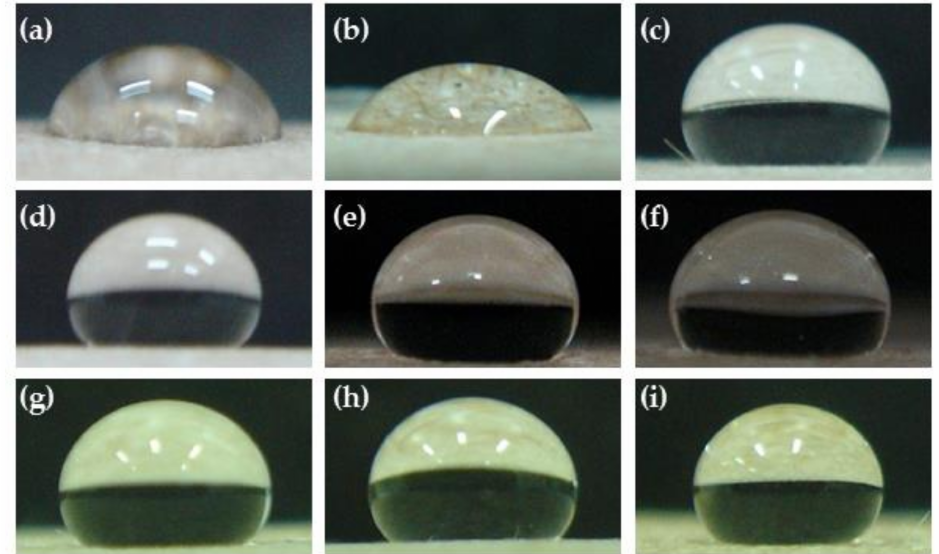
Figure 5. Effect of treatment time (minutes) on water droplets placed (40 µ L) at 200 mTorr and 50 Watts for ( a ) untreated, ( b ) 1 min, ( c ) 3 min, ( d ) 5 min, ( e ) 7 min, ( f ) 10 min, ( g ) 15 min, ( h ) 20 min, and ( i ) 30 min.